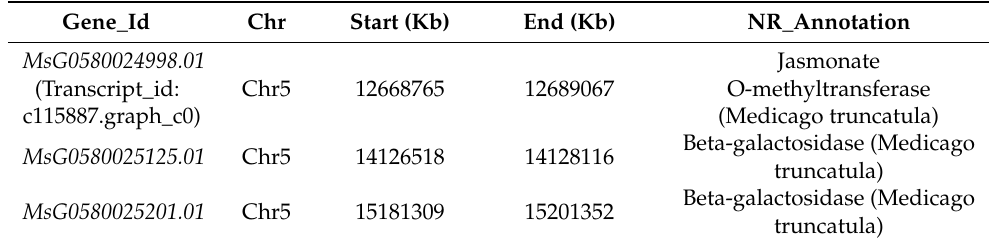
Table 6. The 3 candidate DEGs commonly existing in BAS-seq and BSR-seq